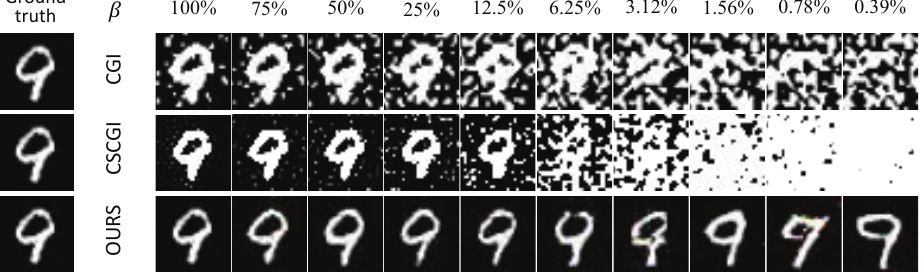
Figure 4. Comparison of simulation results from CGI, CSCGI, and our scheme (labeled as OURS) at different values of β